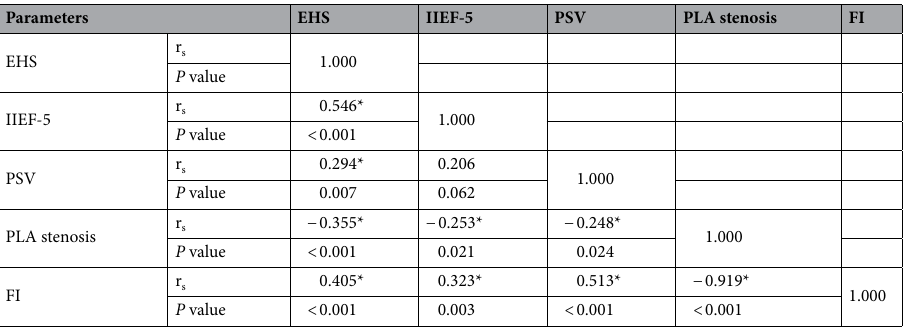
Table 2. Correlation between erectile function and objective measurements. The FI had better correlations with erectile function than PSV. EHS erection hardness score, FI flow index, IIEF-5 the simplified International Index of Erectile Function, PLA pelvic artery, PSV peak systolic velocity. Spearman’s rank correlation coefficient, * P < 0.05.